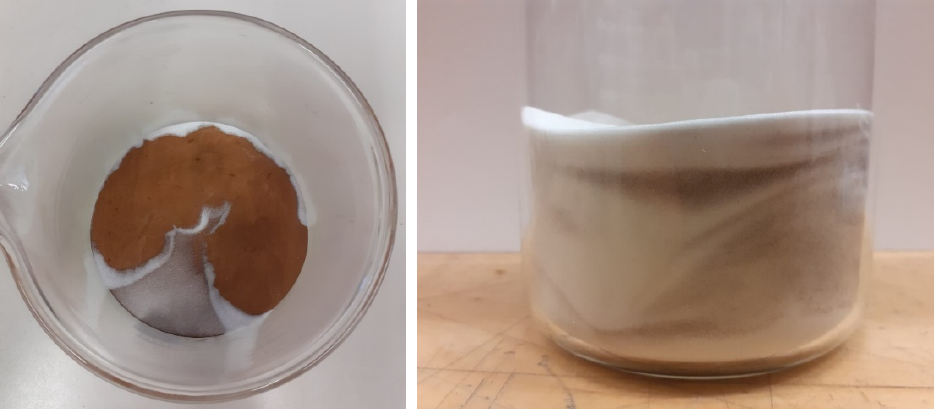
Figure 4. Quartz sand and metallic CuSn12 powder before and after their